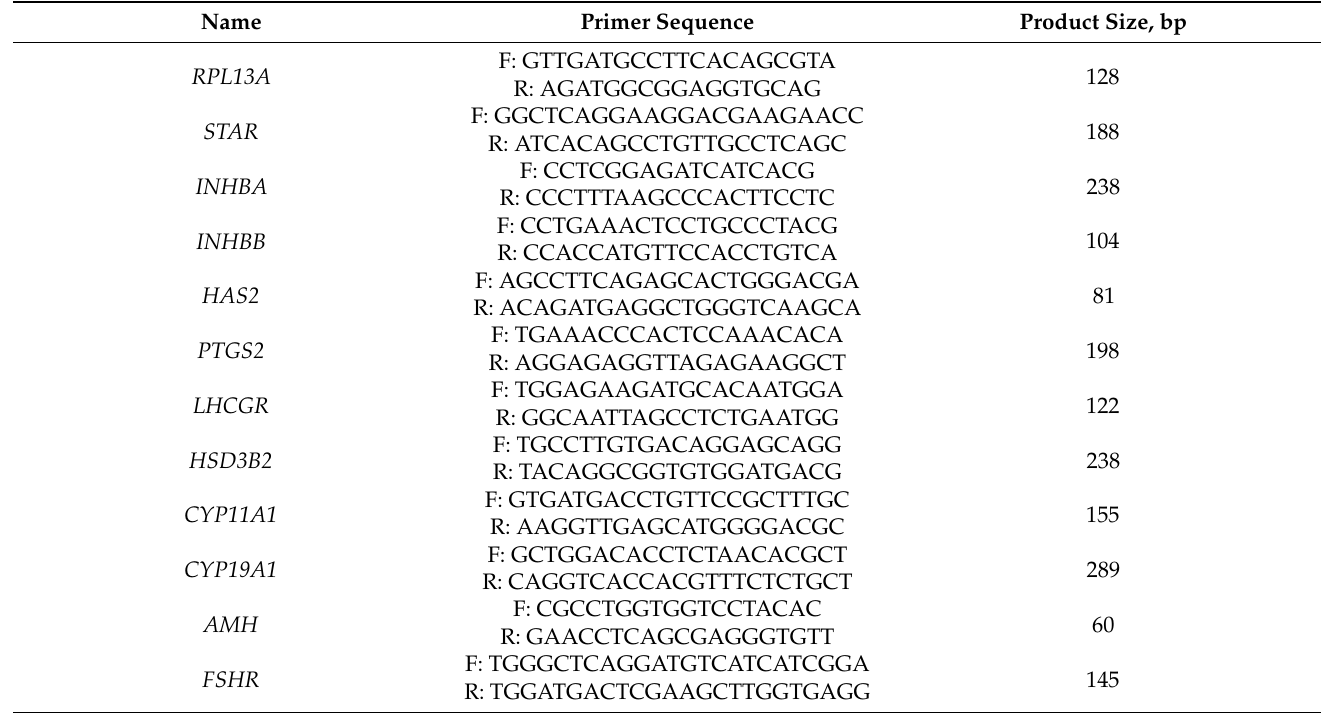
Table 2. List of primers